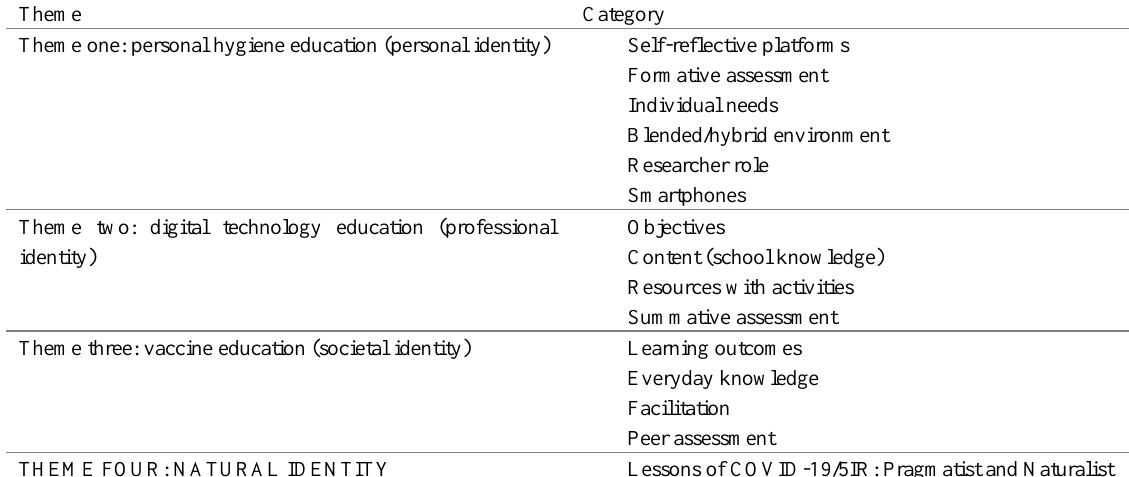
Table 1: Themes and Categories of Findings